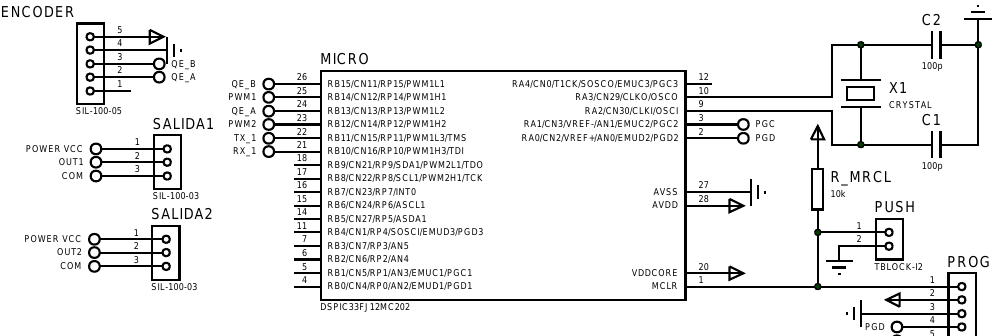
Figure 2. Minimum circuit required for